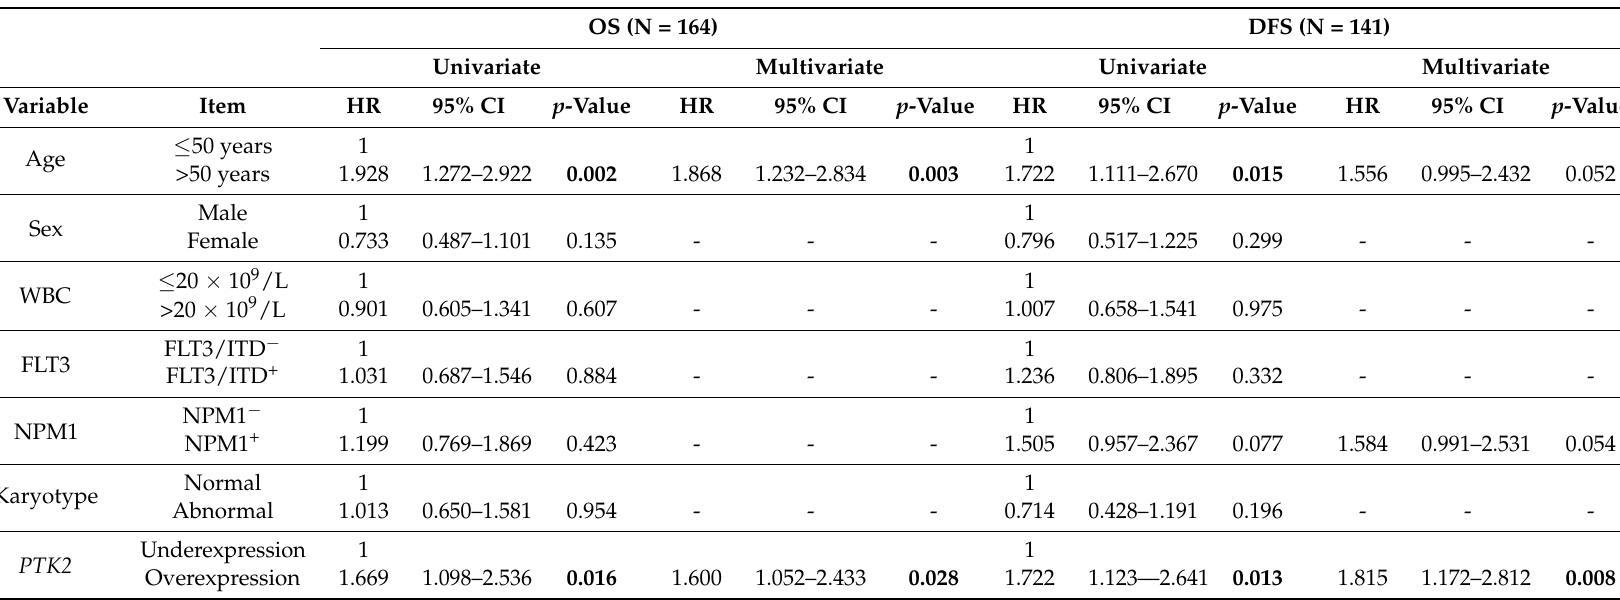
Table 7. Univariate and multivariate of the association between relevant clinical variables and PTK2 expression with OS and DFS in patients with cytogenetic IR-AML and non-favorable FLT3/NPM1 combinations that underexpress LYN